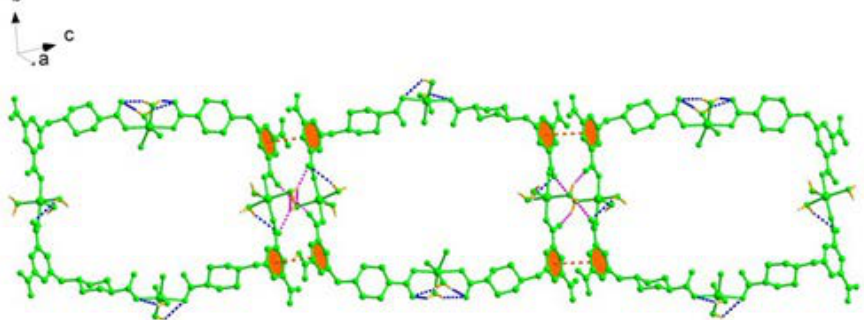
Figure 2. The packing diagram built from a 1D chain by rich hydrogen bonds and π - π stacking interaction.